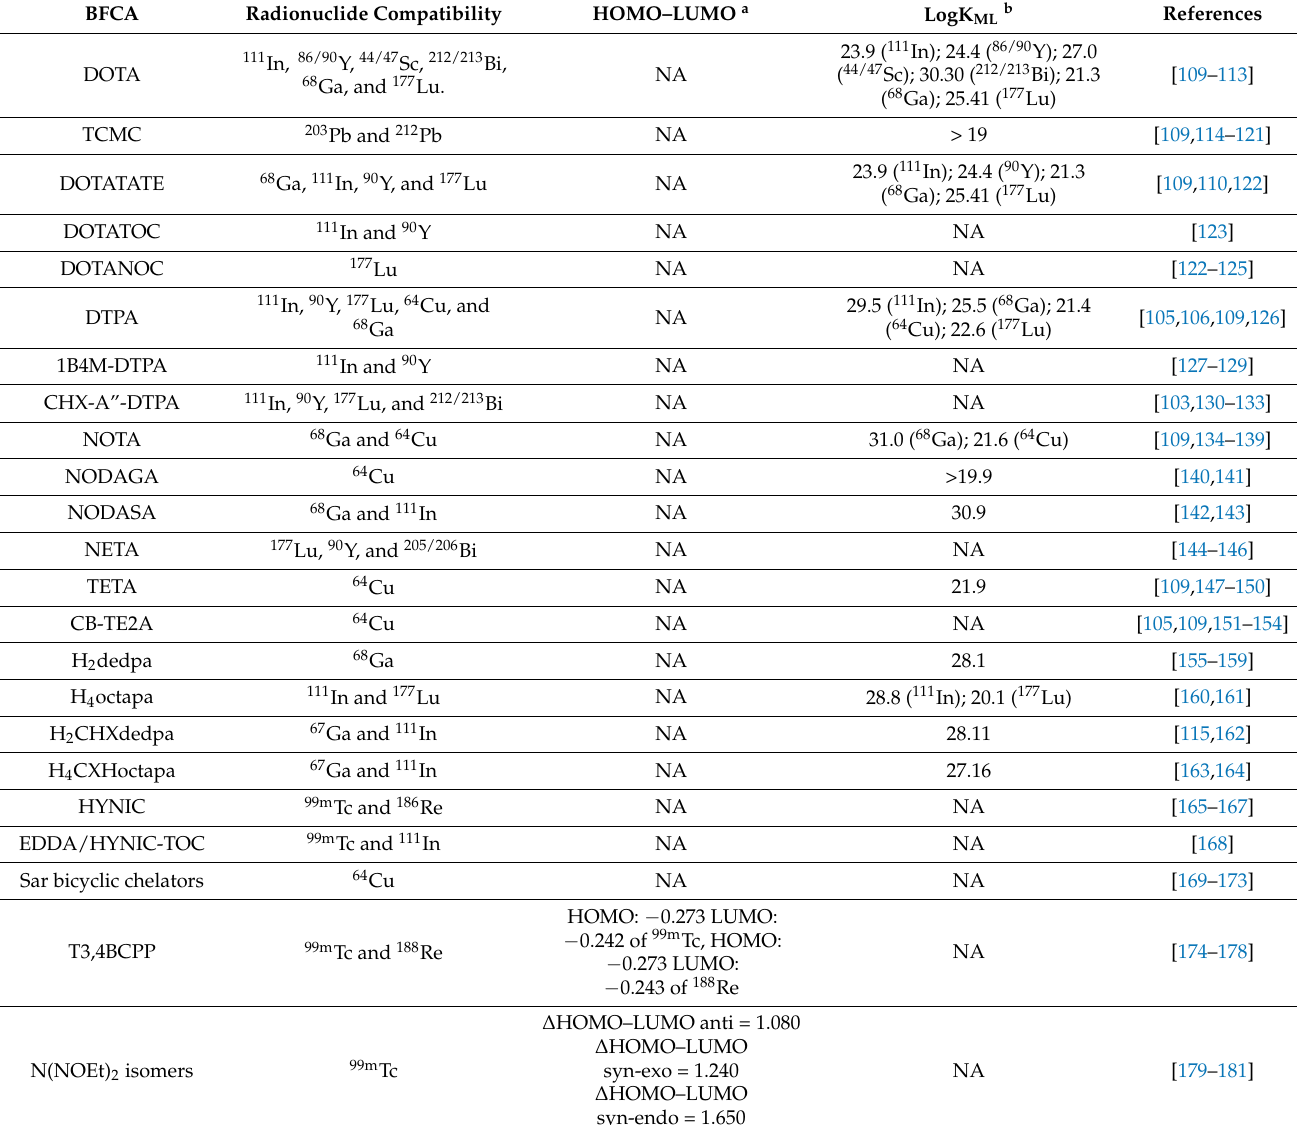
Table 4. Bifunctional Chelating Agents